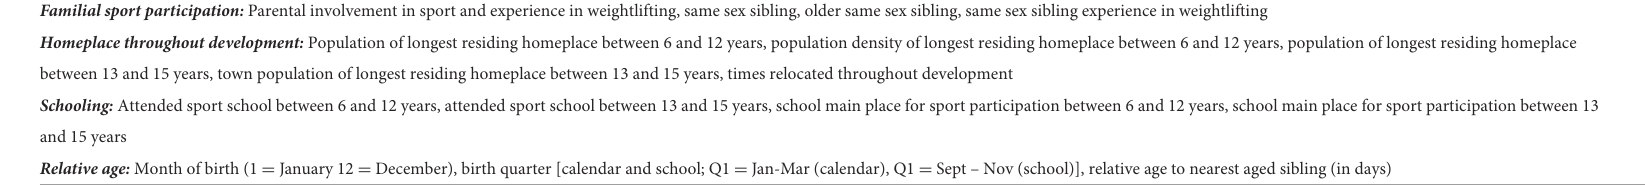
TABLE 1 Features used as part of the multidimensional